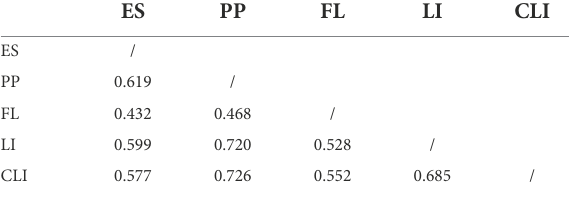
TABLE 7 Results of Heterotrait-monotrait ratio.